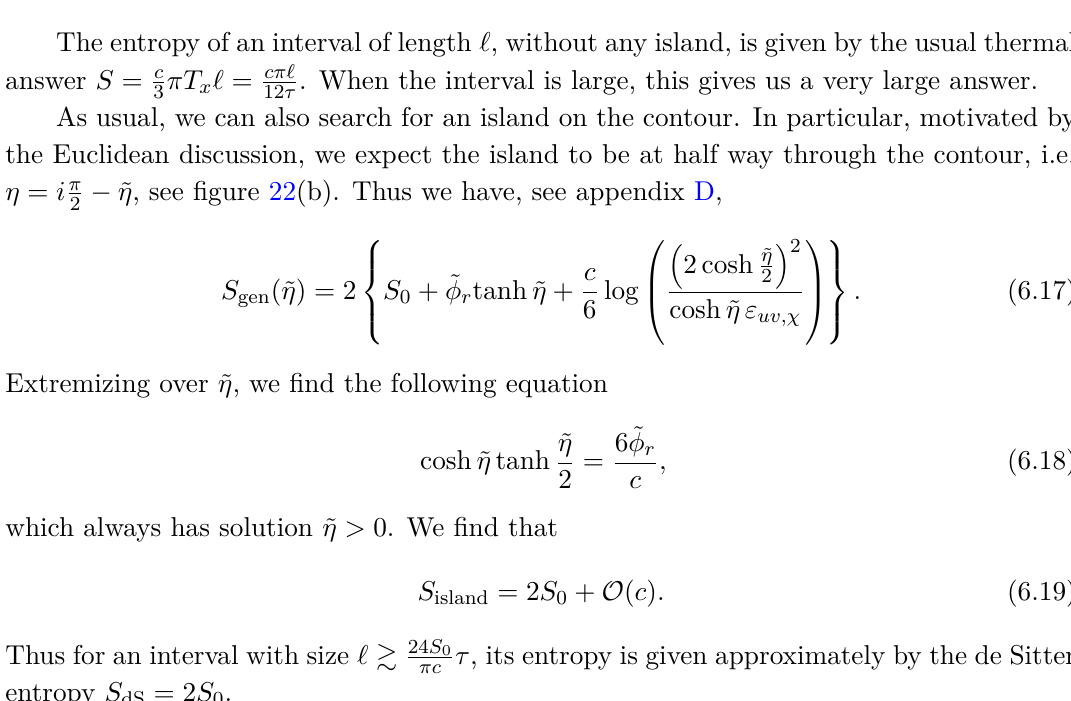
Figure 22 . Regularized π contour. We add further Euclidean time evolution in the flat space region, which is denoted by the yellow lines. (a) Basic contour defining the density matrix. (b) Location of Islands for long intervals. (c) We can further evolve in Lorentzian time, t L , the state prepared in